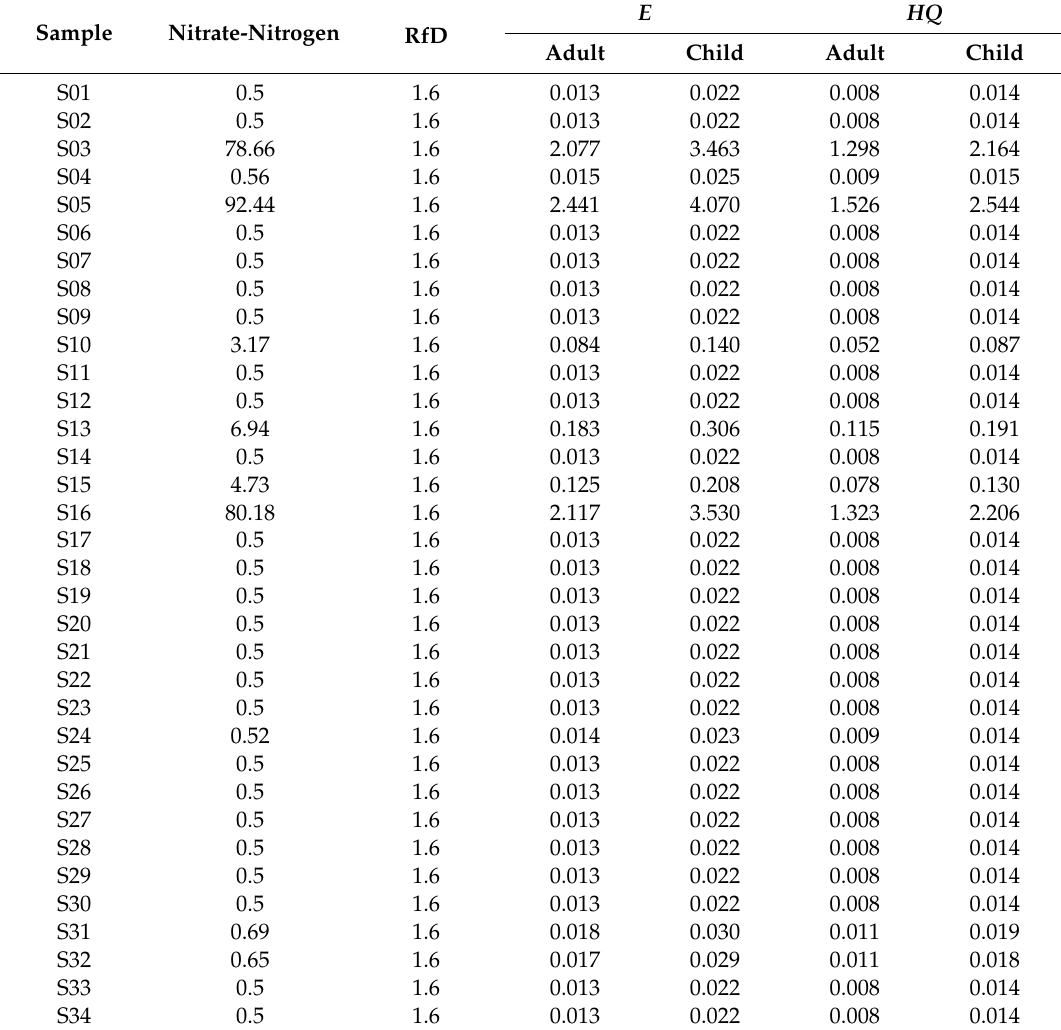
Table 4. The exposure dosage through drinking water intake ( E ) and the hazard quotient of nitrate-nitrogen (mg / L) for the drinking water in Fuyang